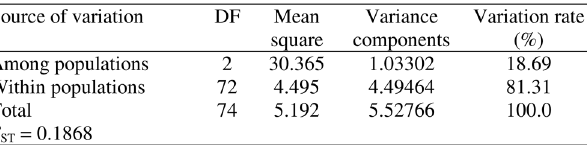
Table 4. Analysis of molecular variance for the three popula- tions of Astyanax aff. bimaculatus studied (all values showed statistically significant differences, P<0.0001).